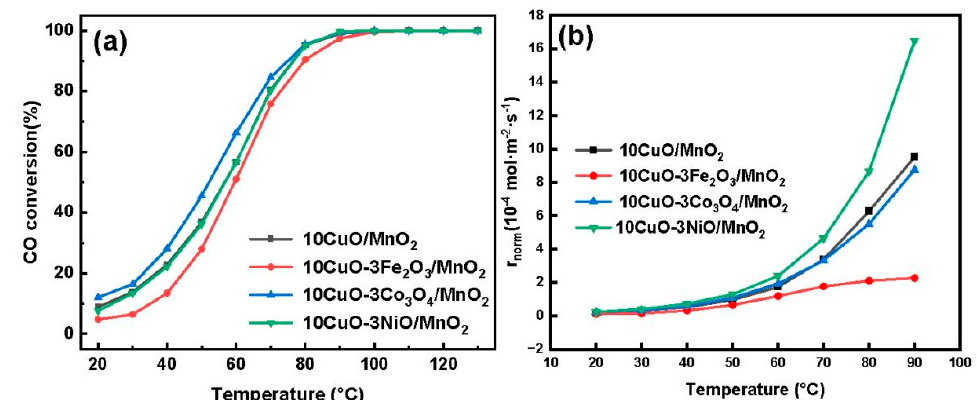
Figure 7. ( a ) CO conversions and ( b ) normalized reaction rates over the 10CuO-3MOx/ α -MnO 2 -400 (MOx = Fe 2 O 3 , Co 3 O 4 , NiO) catalysts under the reaction conditions: CO/O 2 /N 2 = 1/20/79, GHSV = 12,000 mL·g − 1 ·h − 1 , 1 atm.